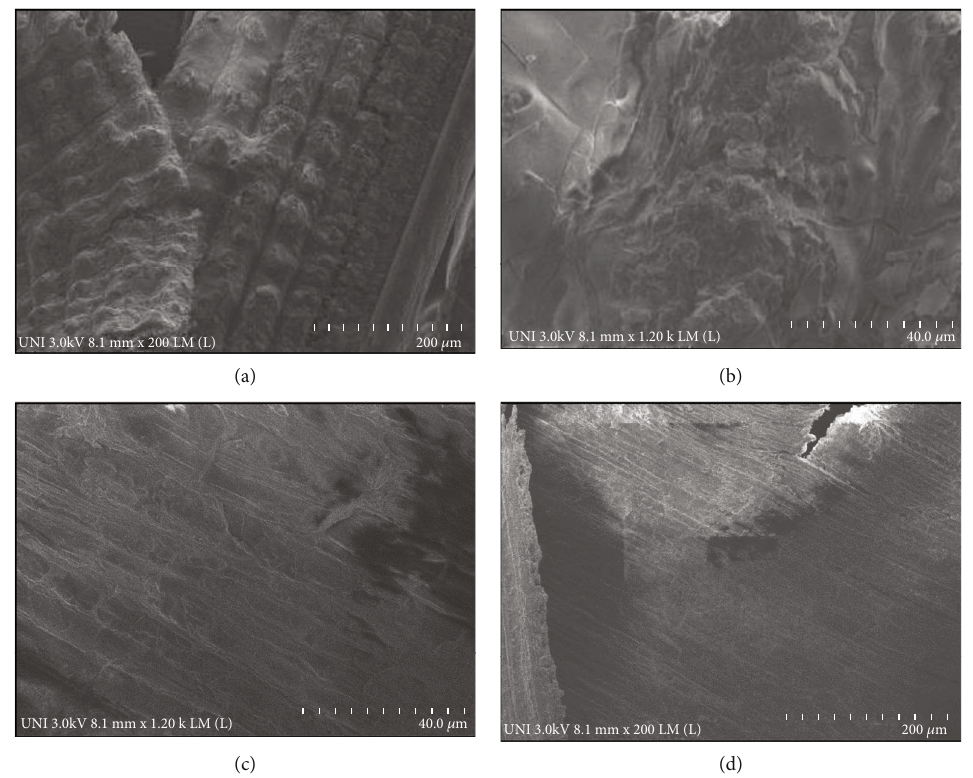
Figure 5: Scanning electron microscopy of rice husk treated with NaOH: (a) and (b) external part ( × 200), (c) external part ( × 1200), and (d) internal part ( ×